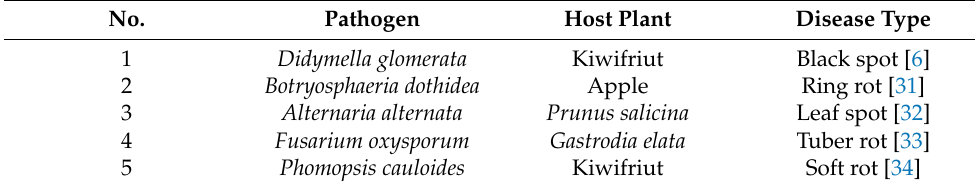
Table 1. The pathogens used in antifungal activity test. No. Pathogen Host